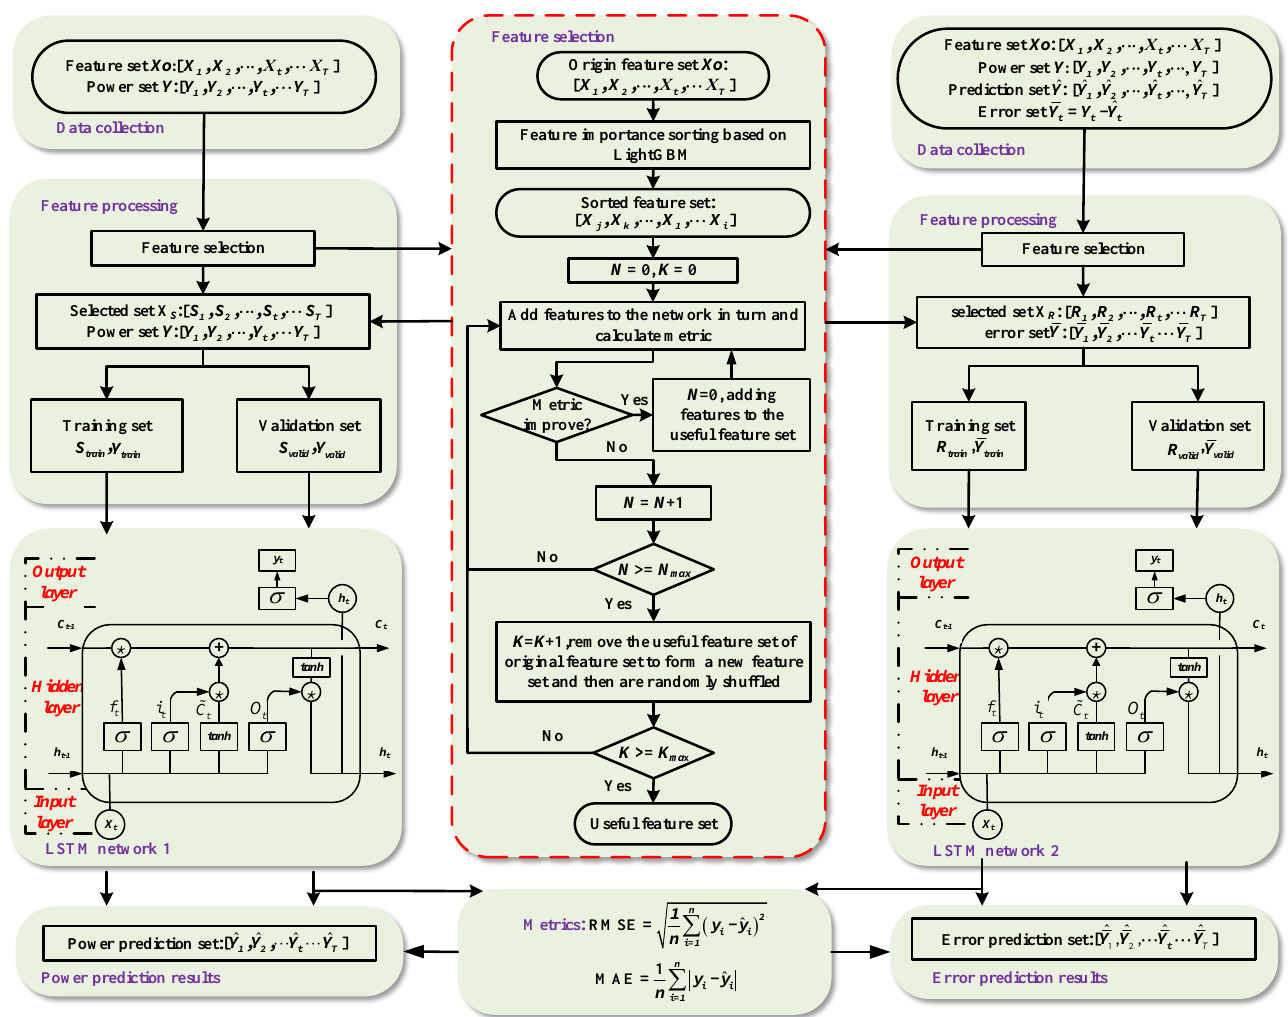
Figure 3. Flow chart of PV short-term power prediction based on feature optimization method and BC–LSTM network.